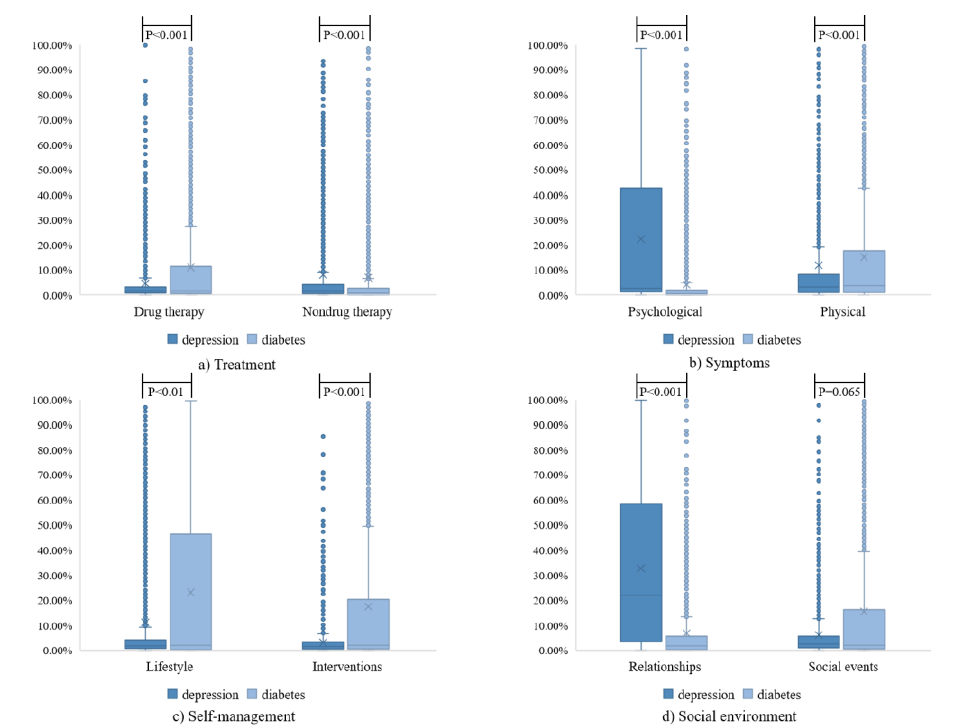
Figure 5. Document topic probability distribution of depression and diabetes communities. ( a ) The topic “Treatment”; ( b ) The topic “Symptoms”; ( c ) The topic “Experience”; ( d ) The topic “S ocial En-vironment”.